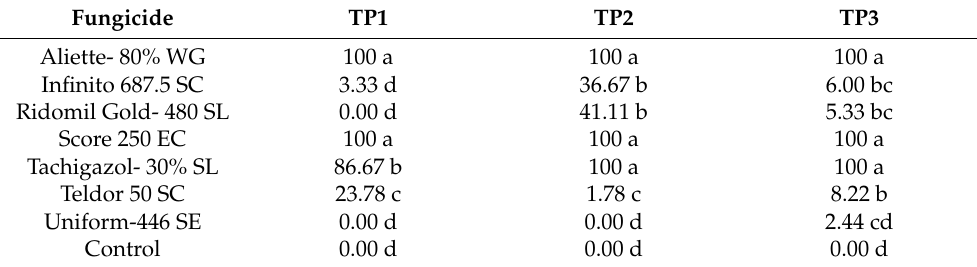
Table 2. Percentage colony growth inhibition of three isolates of Thielaviopsis punctulata using seven